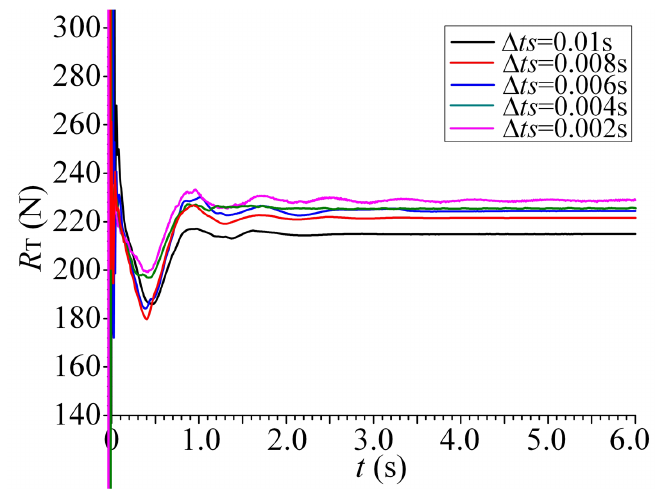
Figure 14. Resistance curves of the different time steps.